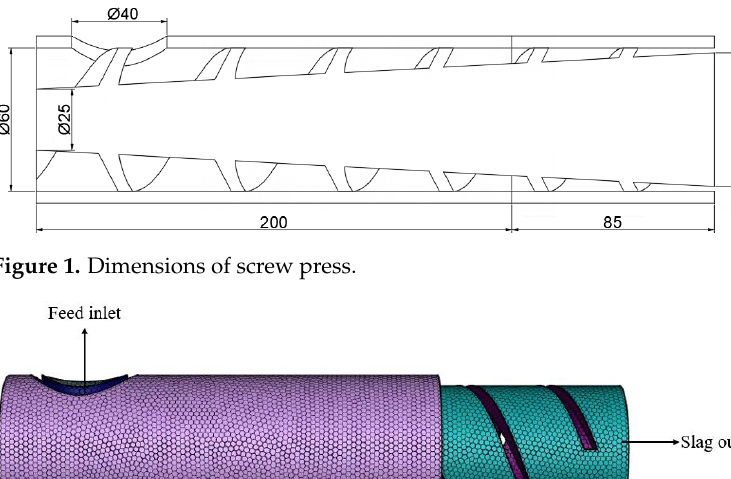
Figure 2. Computational domain mesh of screw press .